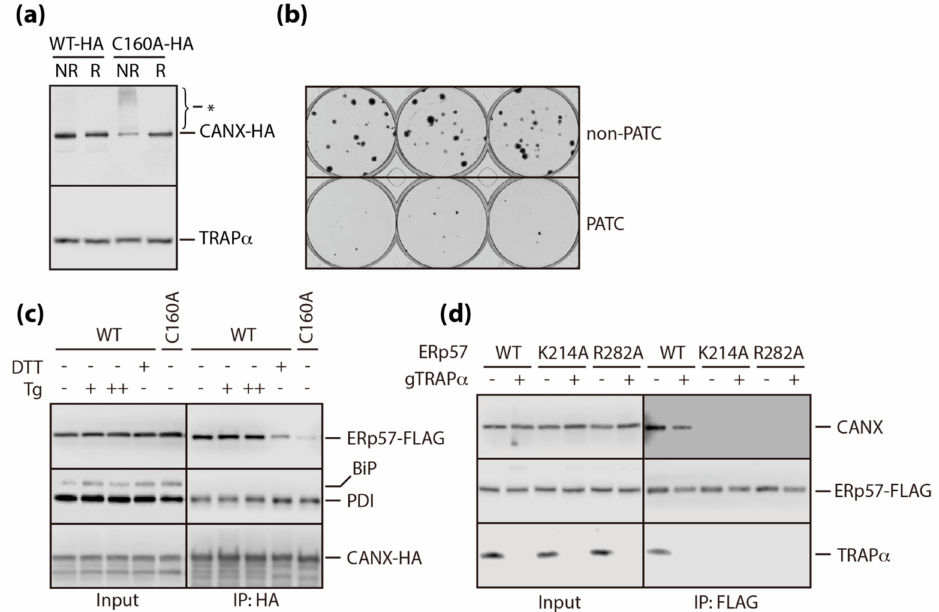
Figure 5. Analyses of the interaction between ERp57 and calnexin. ( a ) Fully solubilized stable / inducible cells expressing wild-type (WT) or mutant calnexin (C160A) fused with HA were subjected to immunoblotting with an anti-HA antibody, under reducing (R) and non-reducing (NR)